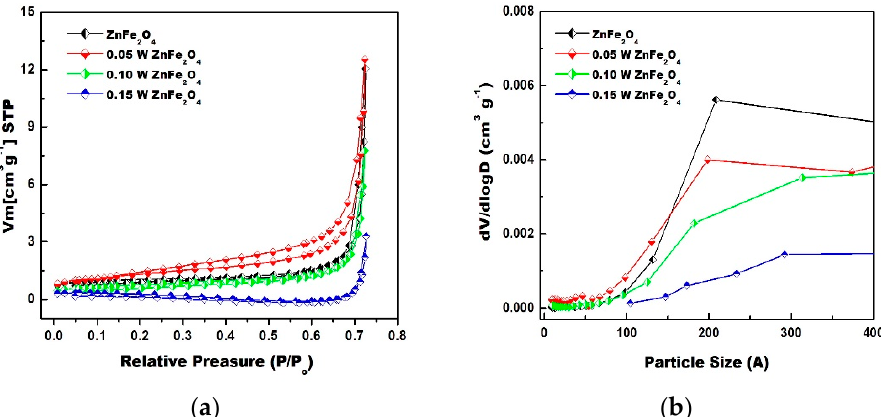
Figure 6. Nitrogen adsorption–desorption isotherm ( a ) and BJH pore size distribution ( b ), graphs of ZnFe 2 O 4 , ZnW 0.05 Fe 1.95 O 4 , ZnW 0.1 Fe 1.90 O4, and ZnW 0.15 Fe 1.85 O